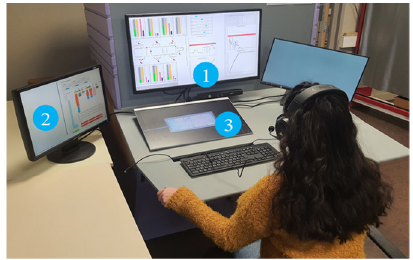
Figure 4. Production workplace (Organization 2). (1) Production control interface; (2) Planning interface; (3) Bird’s eye view of the production cell.